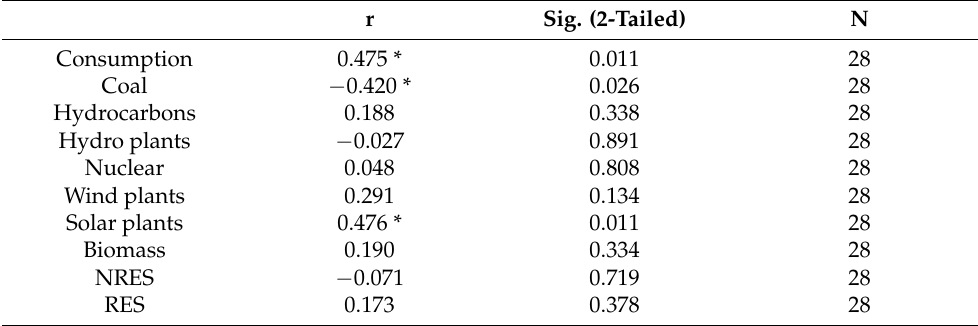
Table 6. Pearson correlation between GDP and electricity produced from different types of fuels, between Q1 2013 and Q4 2019. r Sig. (2-Tailed) N Consumption 0.475 *